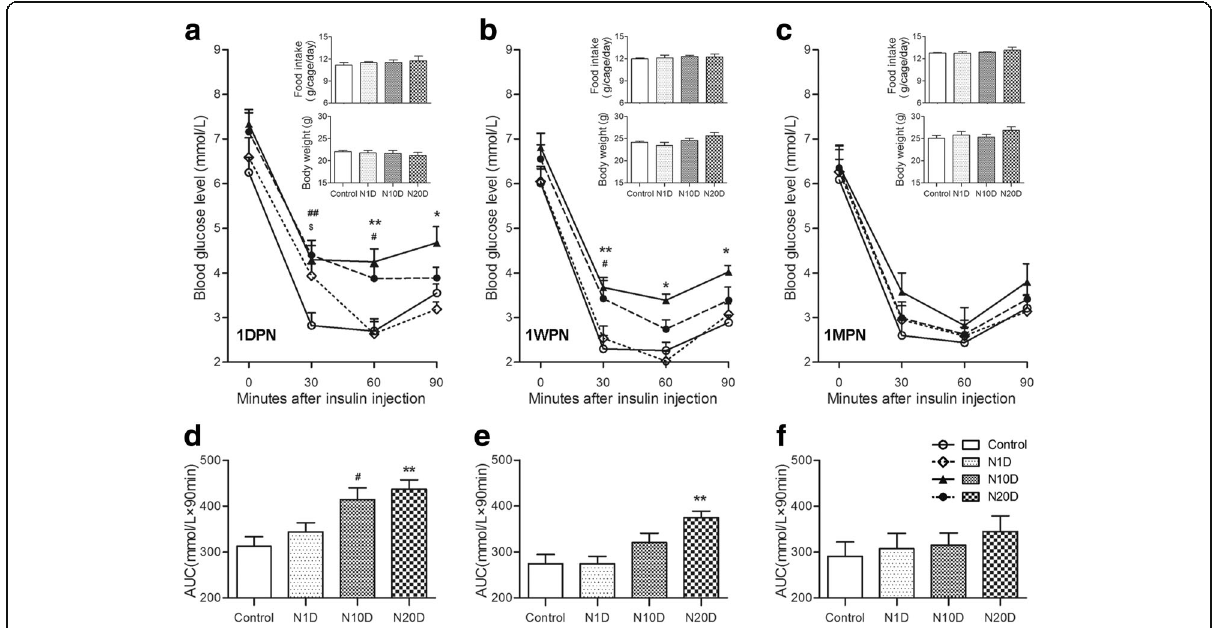
Fig. 2 Effect of noise exposure on systemic insulin sensitivity in mice. a – c Blood glucose levels during the ITTs in 4-h-fasted mice were assessed at 1DPN, 1WPN, and 1MPN. The inserts show the average daily food intake of the corresponding animals measured on a per-cage basis and body weight measured just before the ITT. d – f The areas under the curves (AUC) for blood glucose are shown in a – c , respectively. Values are presented as the means ± SEM of 8 mice per group. * p < 0.05 and ** p < 0.01 indicate significance in post hoc comparisons between N20D and the control group after a two-way RM ( a – c ) or one-way ( d – f ) ANOVA, showing a significant effect of noise. # p < 0.05 and ## p < 0.01: N10D vs control group. $ p < 0.05: N1D vs control